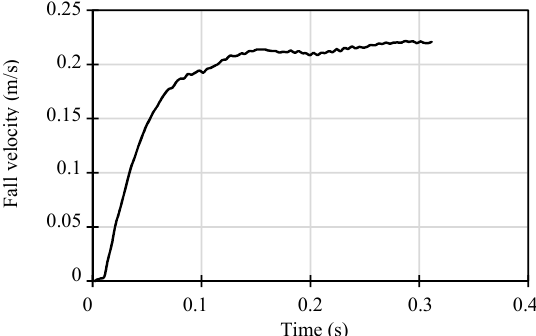
Fig. 5. Velocity magnitude contour of particle with diameter of 0.77 mm